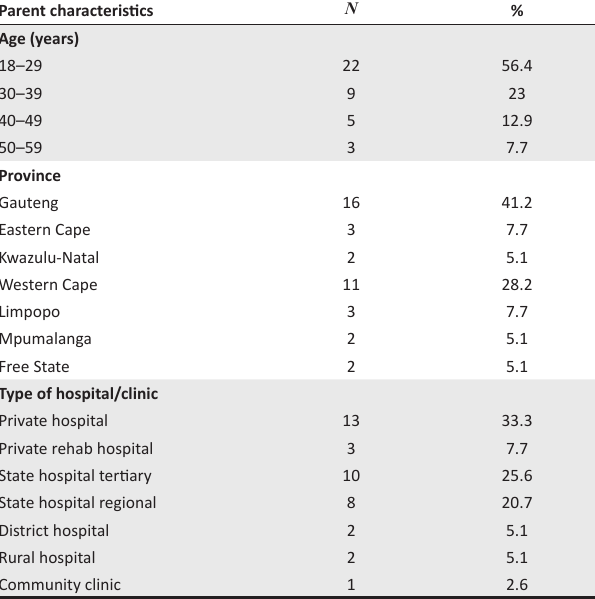
TABLE 1: Participant description and